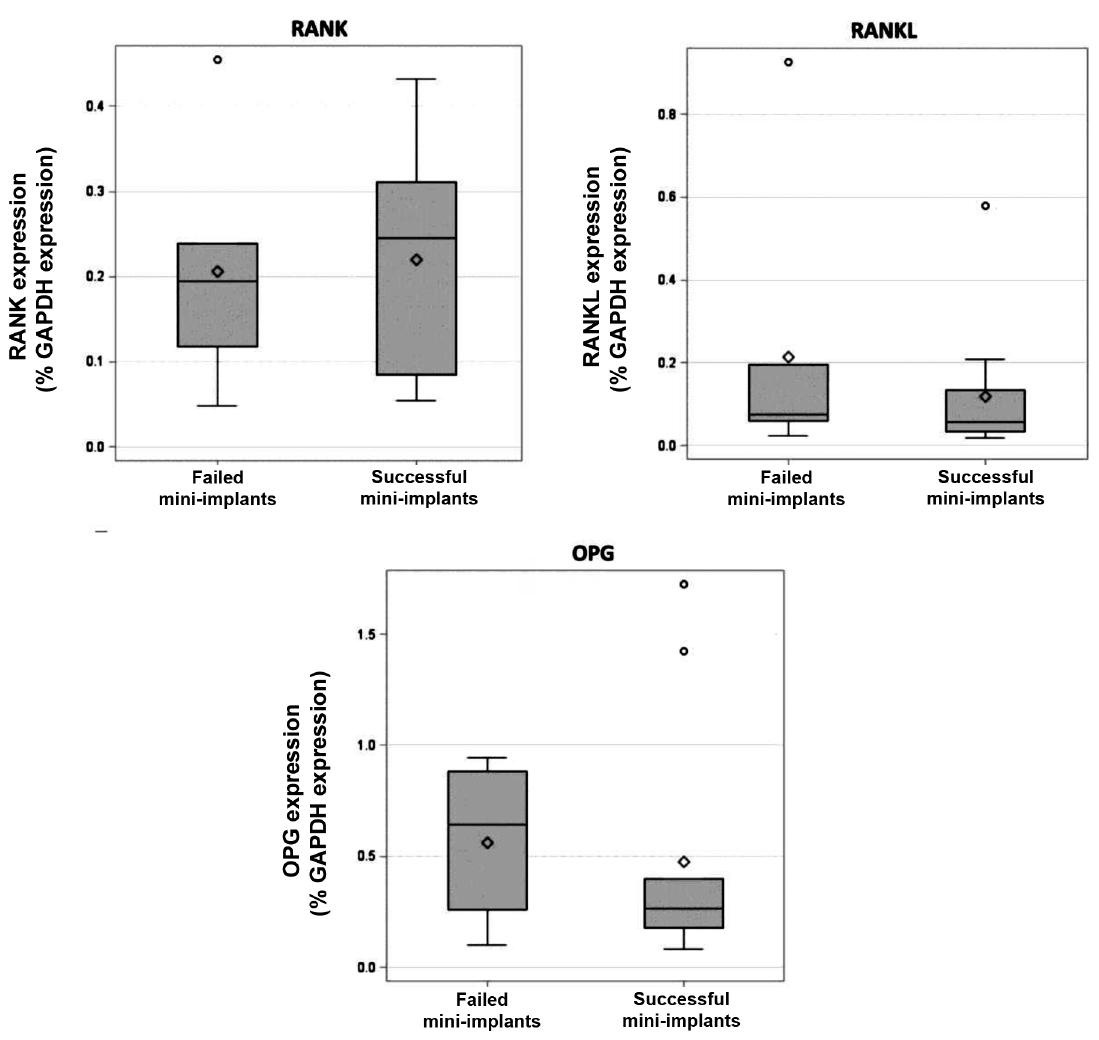
Figure 2- Quantification of osteoclastogenesis markers RANK, RANKL, and OPG, presented in box-plots as percentage of GAPDH expression, in gingival tissue around successful and failed mini-implants. Wilcoxon rank-sum